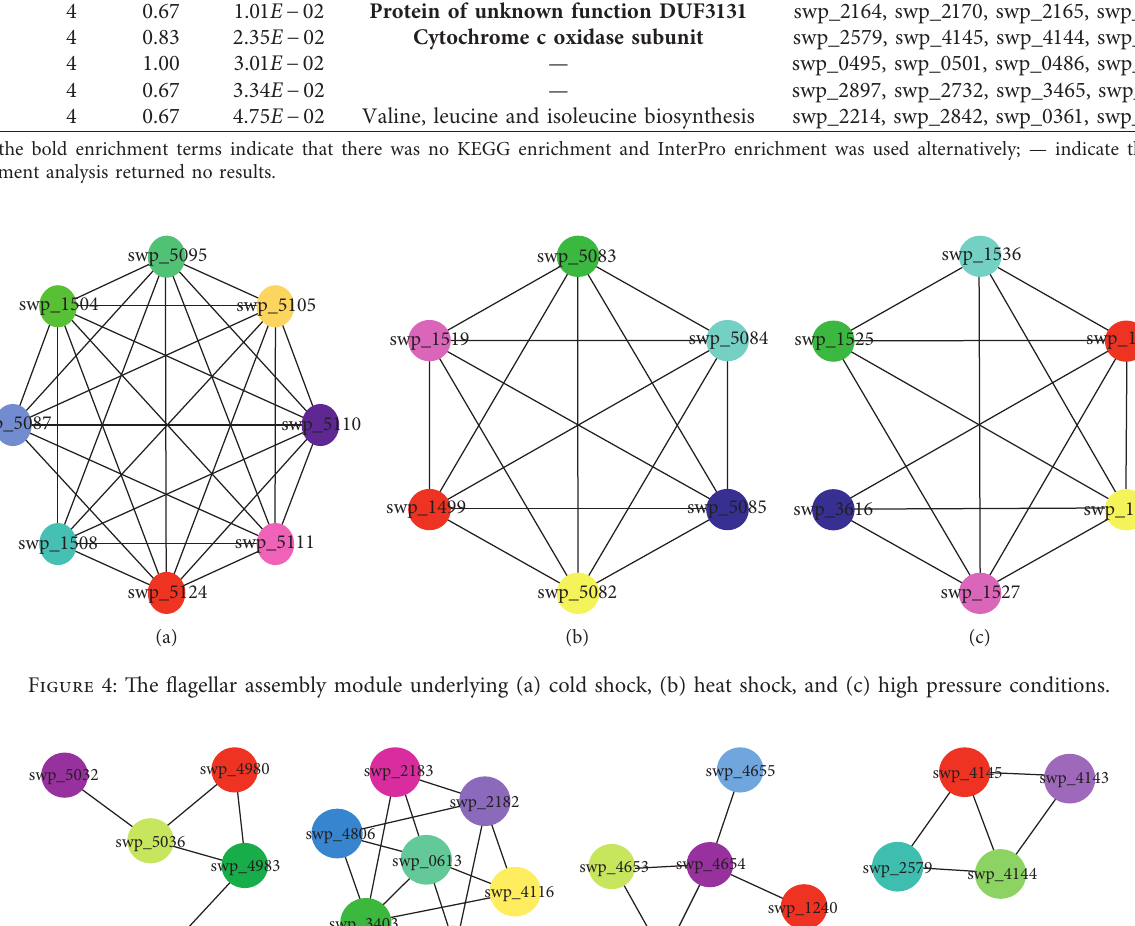
Table 5: The most representative KEGG pathway that was enriched in the modules identified from the salt shock condition. Cluster Size